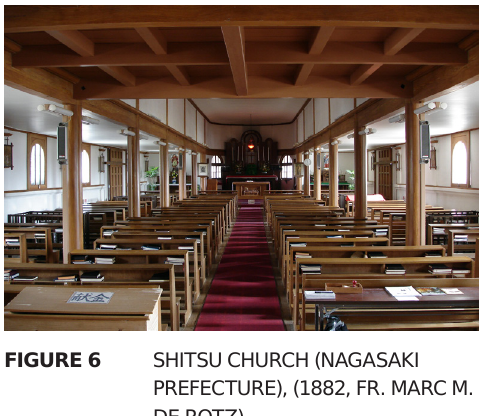
FIgure 6 SHITSU CHURCH (NAGASAKI PREFECTURE), (1882, FR. MARC M. DE